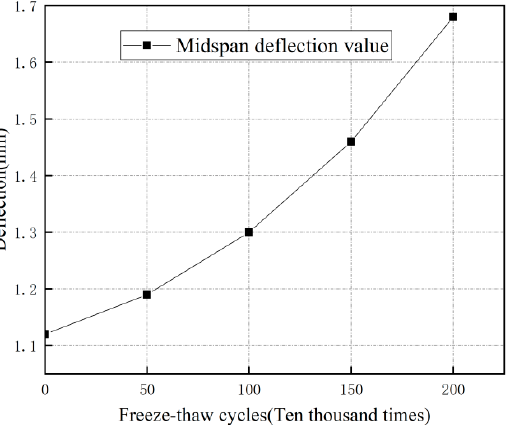
Figure 20. Midspan deflection of reinforced components under different freeze–thaw cycles.